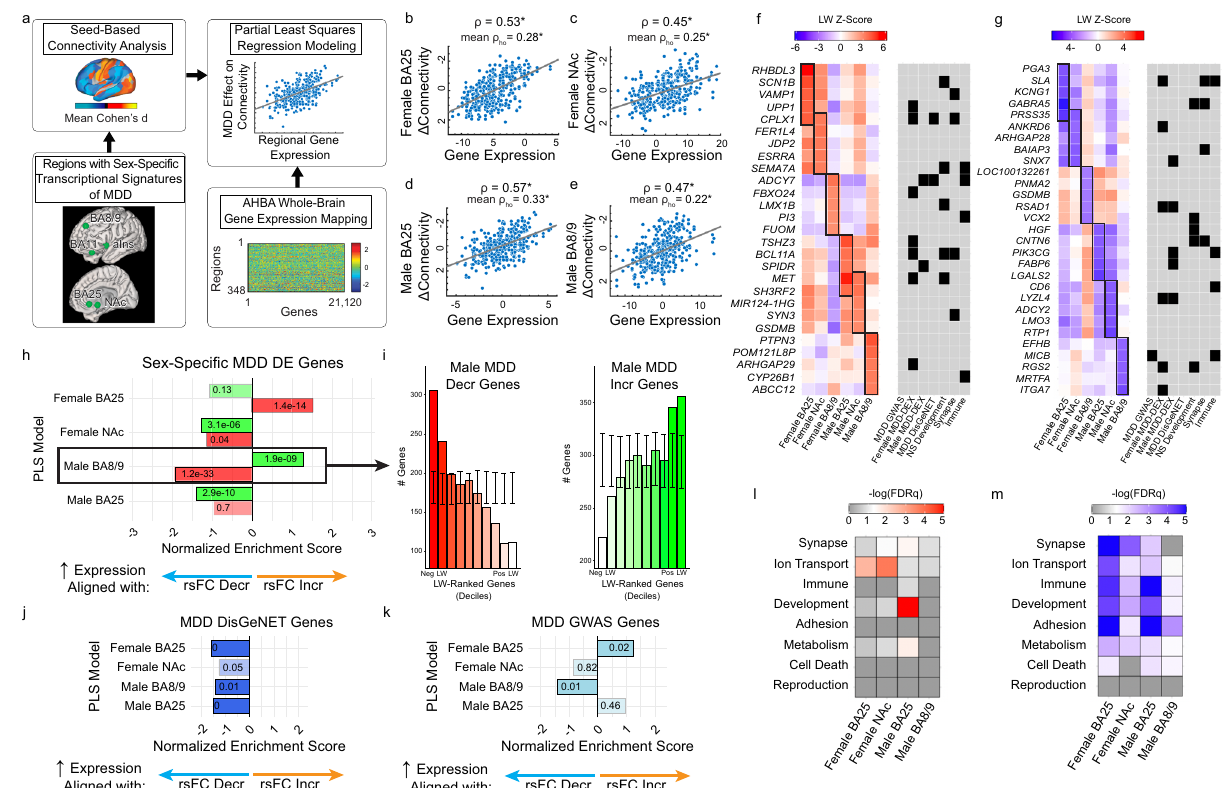
Fig. 4 | Distinct transcriptional signatures underlying sex-dependent rsFC effects in depression. a Schematic representing partial least squares regression (PLS-R) analysis for uncovering spatial relationships between regional gene expressionpatternsandrsFCabnormalitiesin fi vetranscriptomicROIs(BA25,NAc, BA11, BA8/9, aIns). b – e PLS-R identi fi ed multivariate spatial correlations between geneexpressionandrsFCeffectsthatwerestatisticallysigni fi cantandreproducible in cross-validation in four models: female BA25 ( b ), female NAc ( c ), male BA25 ( d ), and male BA8/9 ( e ). In each scatterplot, individual data points represent gene expressionandrsFCeffectsforagivenbrainregion,projectedintoaspacede fi ned bythe fi rstPLScomponent.Thecorrelationforthe fi rstPLScomponent( ρ )andthe